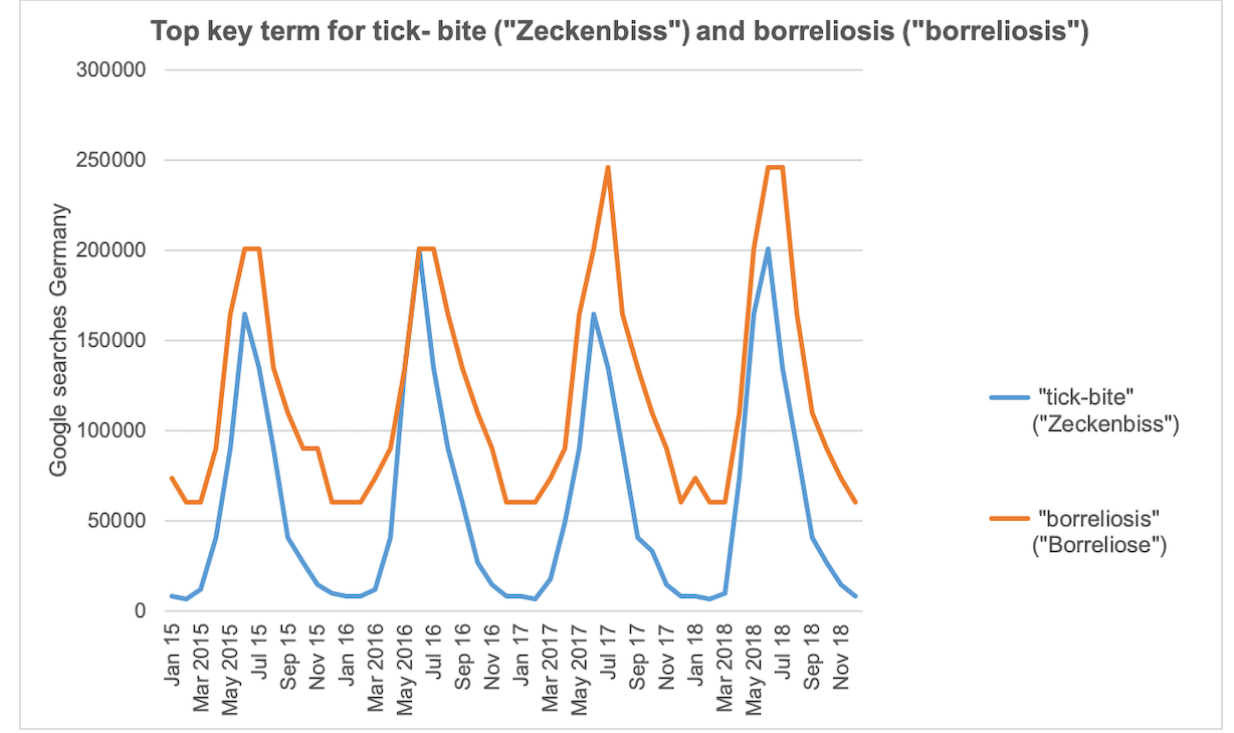
Figure 2. Seasonal variation of the two most common keywords searched for in Germany, “tick-bite” and “borreliosis,” from January 2015 to December 2018.